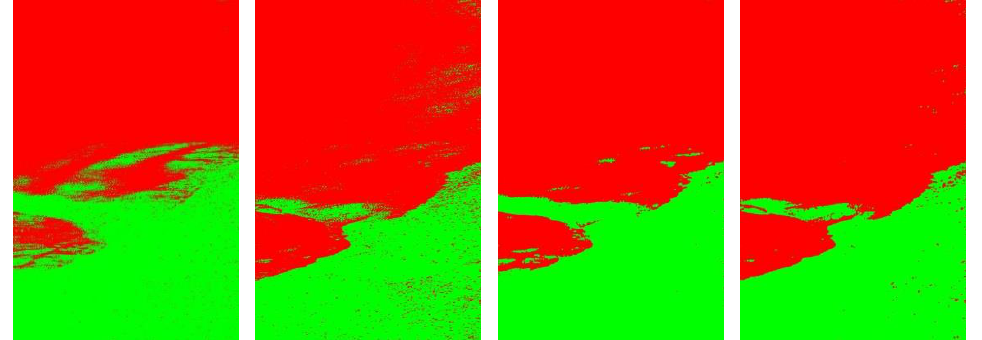
Figure 3 the red tide detection results (From left to right: SVM, CNN, Filter-SVM, Filter-CNN)